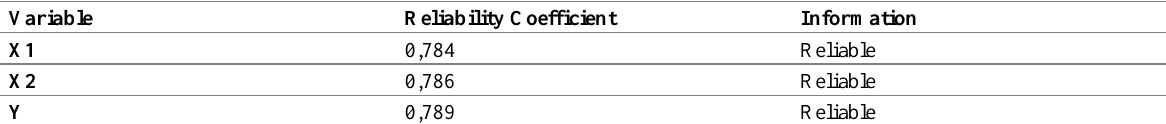
Table 6: Reliability Test Result